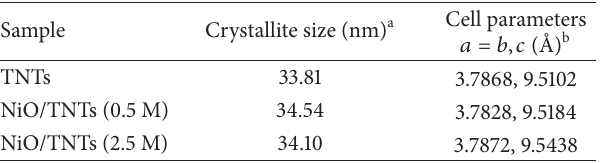
Table 2: Lattice parameters for TNTs and NiO/TNTs samples with different